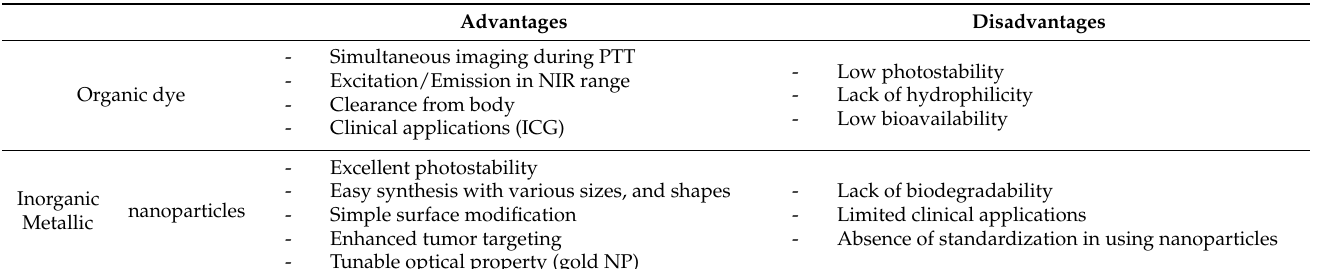
Table 2. Advantages and disadvantages of nanoparticle agents for